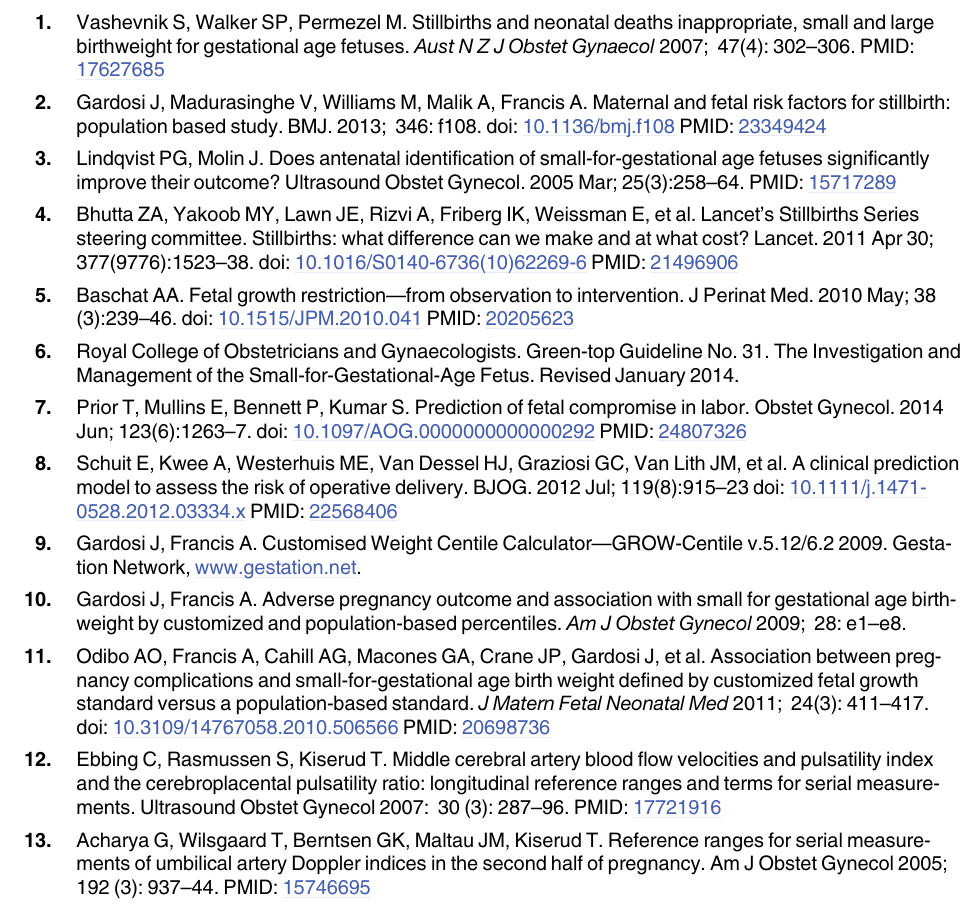
S1 Table. Predictive test characteristics of changing centile as a predictor of operative deliv- ery (Em CS or OVD) for suspected intrapartum fetal compromise; n =